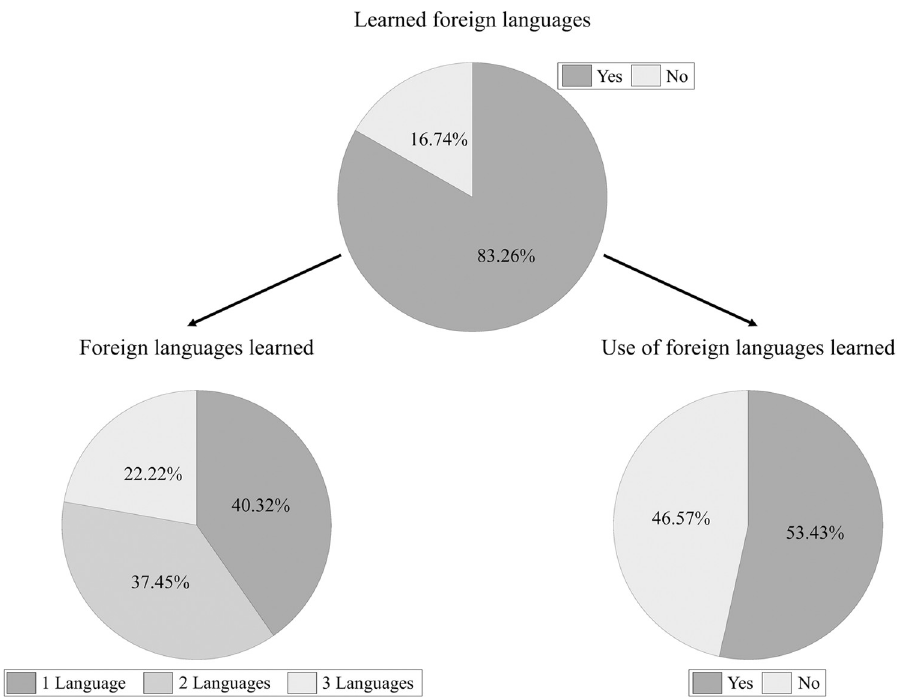
Fig 1. Relative frequency of foreign language learning. The pie chart above represents the proportion of participants who reported having learned (n = 801) or not learned foreign languages (n = 161). Out of the total number of participants who had learned foreign languages, the lower-left pie chart shows the proportion who had learned one (n = 323), two (n = 300), or three (n = 178) foreign languages; the lower-right pie chart shows the proportion who reported use (n = 428) or no use (n = 373) of the foreign languages learned.